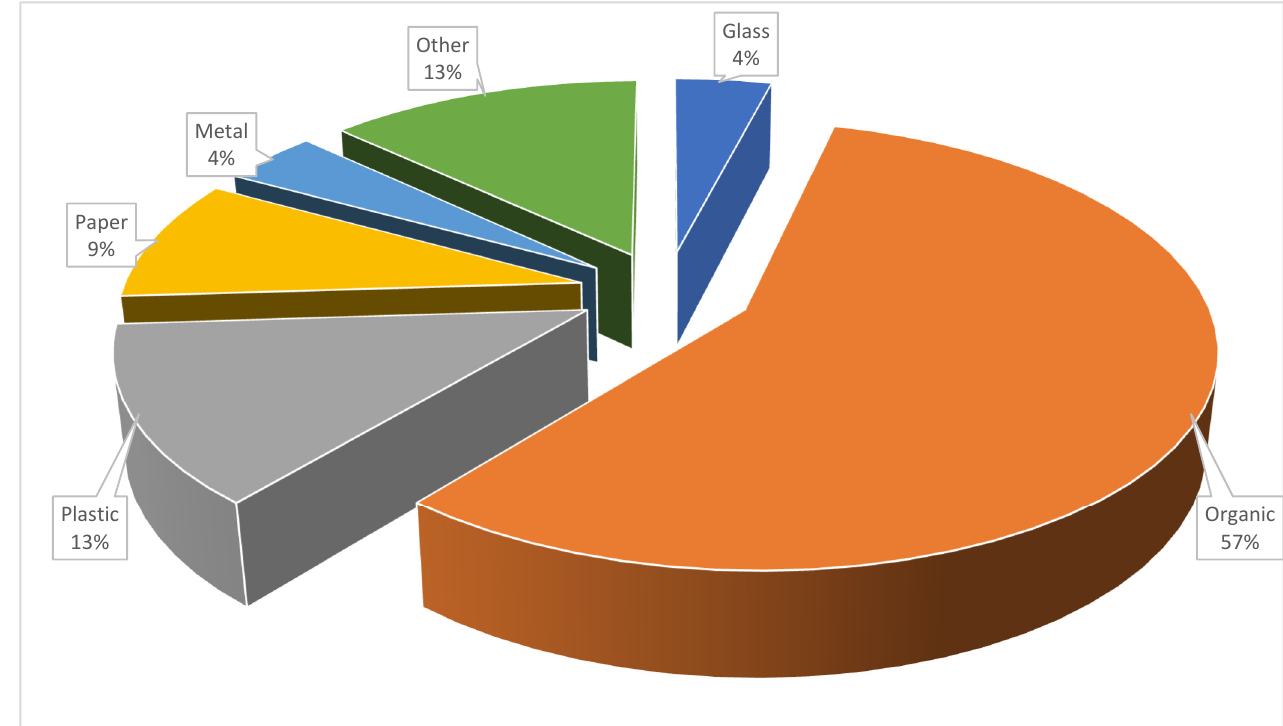
Figure 3. Waste composition in SSA, data from United Nations [20], Hoornweg and Bhada-Tata [26].